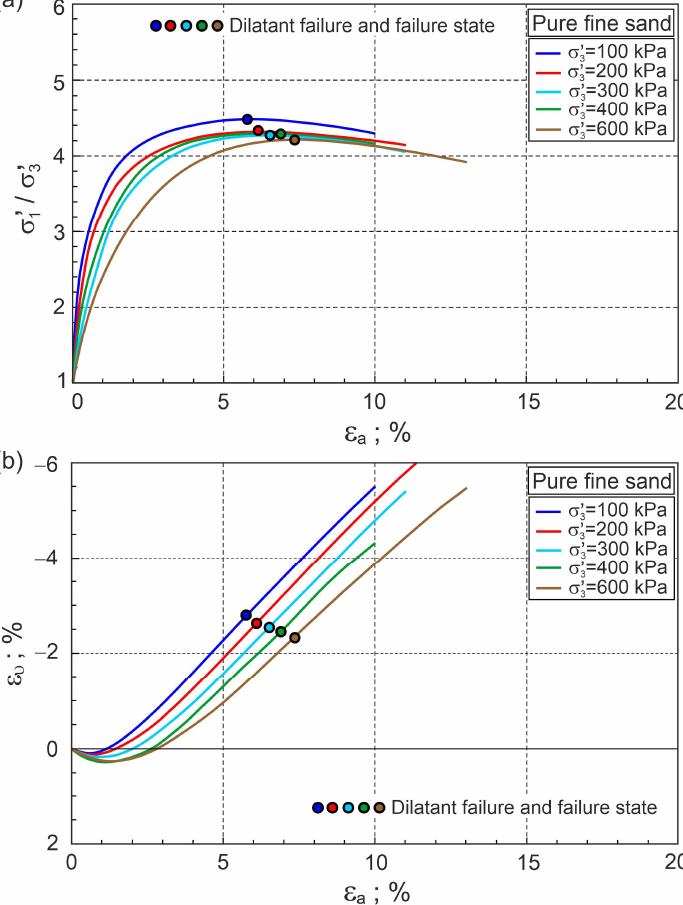
Figure 2. Relationships for pure fine sand: ( a ) (cid:2026) (cid:2869)(cid:4593) (cid:2026) (cid:2871)(cid:4593) ⁄ − (cid:2013) (cid:3028) and ( b ) (cid:2013) (cid:3100) − (cid:2013) (cid:3028) (experimental data from [5]).